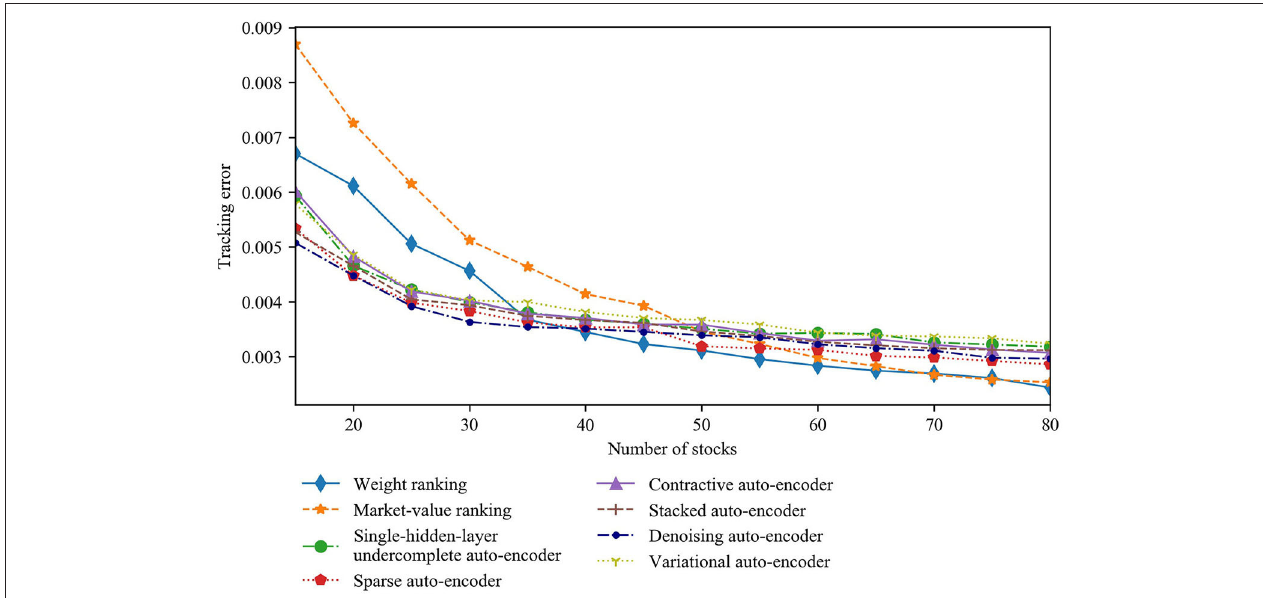
FIGURE 13 | Tracking error curves for all strategies with 5-year training sets.